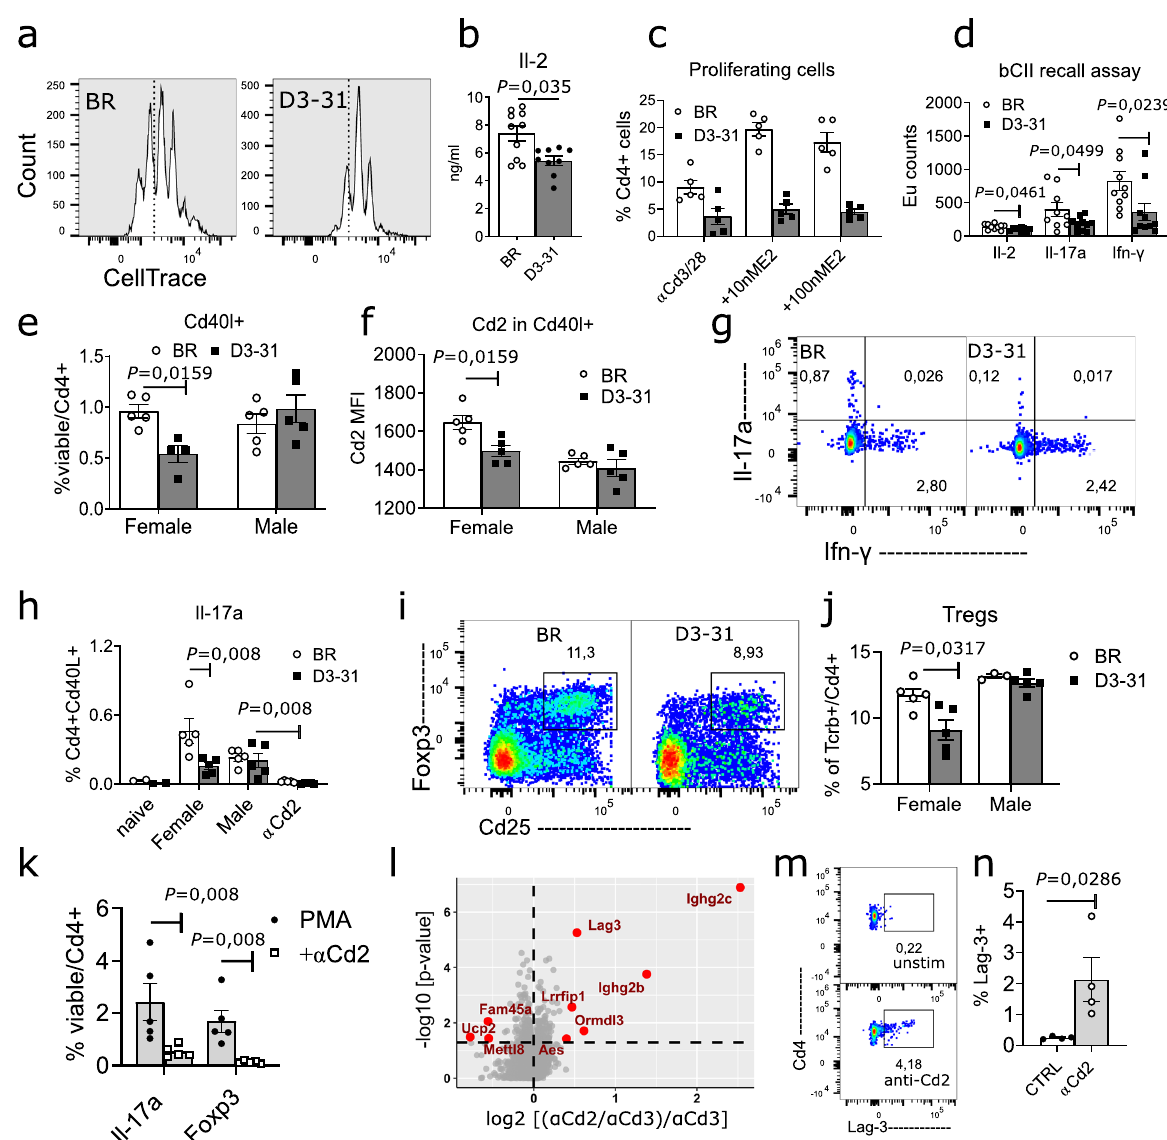
Fig. 6 Sex-speci fi c differences in Cd2 expression limit the T cell responses in female D3-31 mice. a , b Proliferation ( a ) and Il-2 secretion ( b ) of Cd4